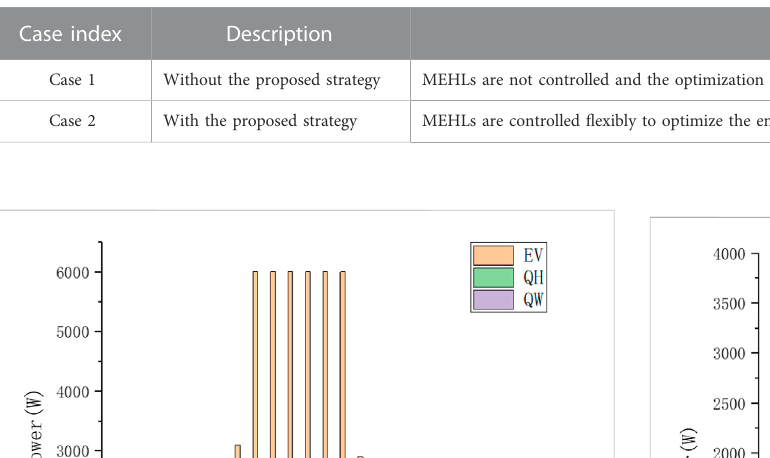
TABLE 1 The settings of two cases.